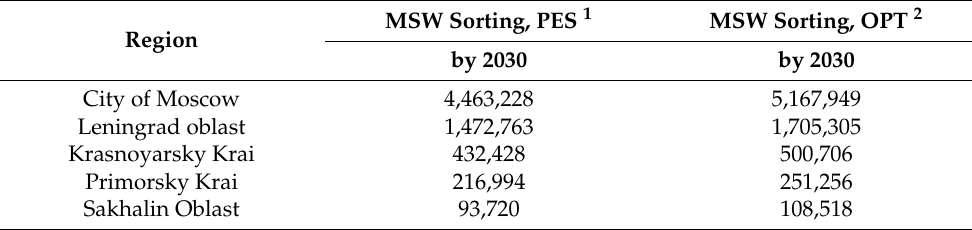
Table 4. Results of forecasting the amounts of MSW sorting in the selected regions of